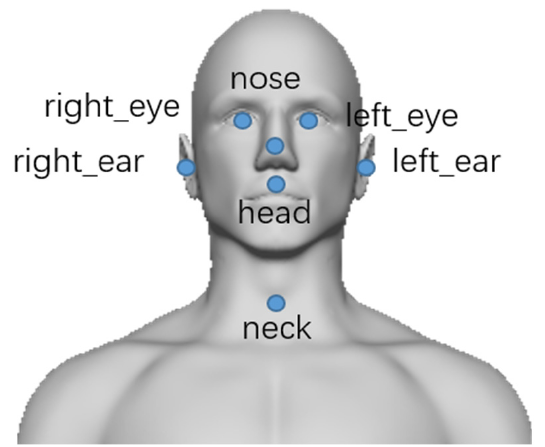
Figure 5. The human keypoints of the subject.